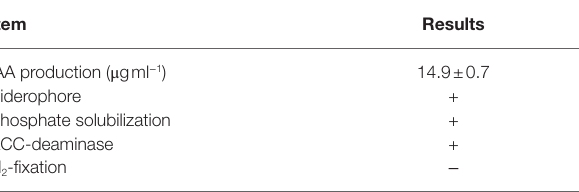
TABLE 3 | Beneficial traits of Pseudomonas monteilii FC02.